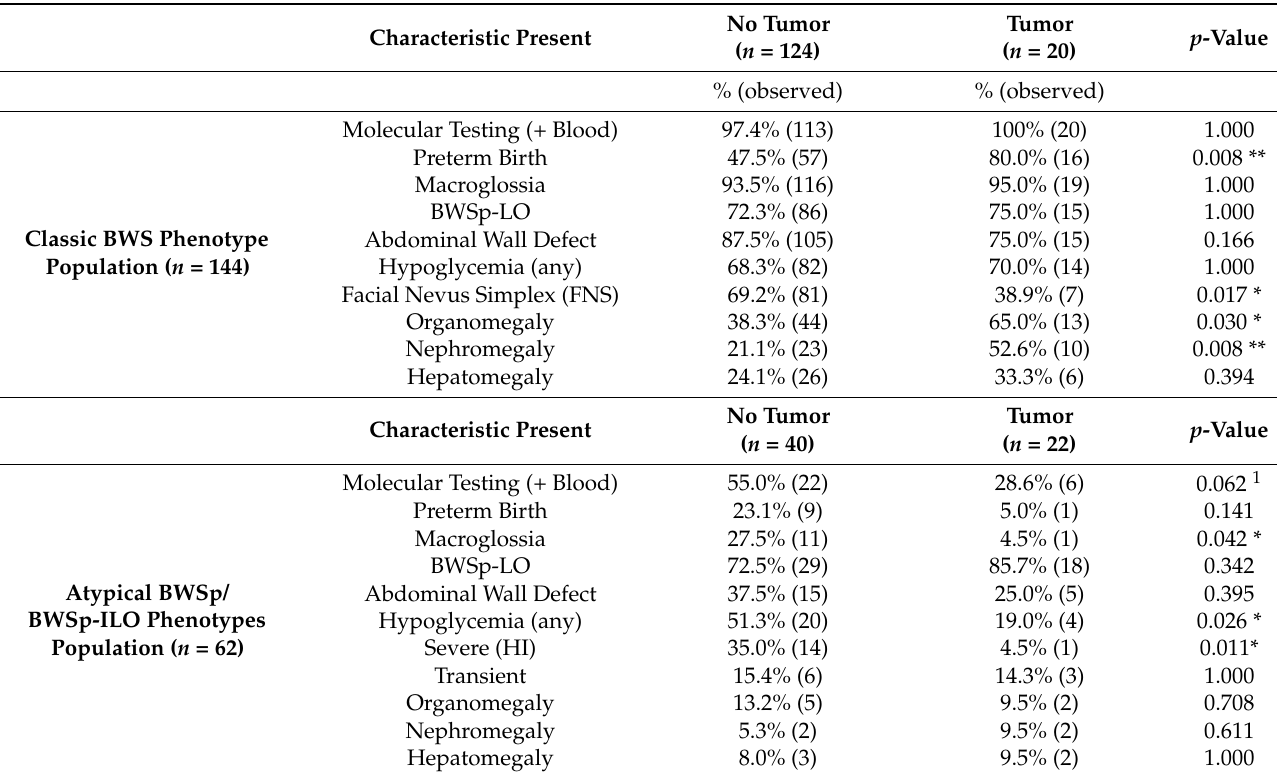
Table 5. Tumor phenotype associations within BWS spectrum population groups.